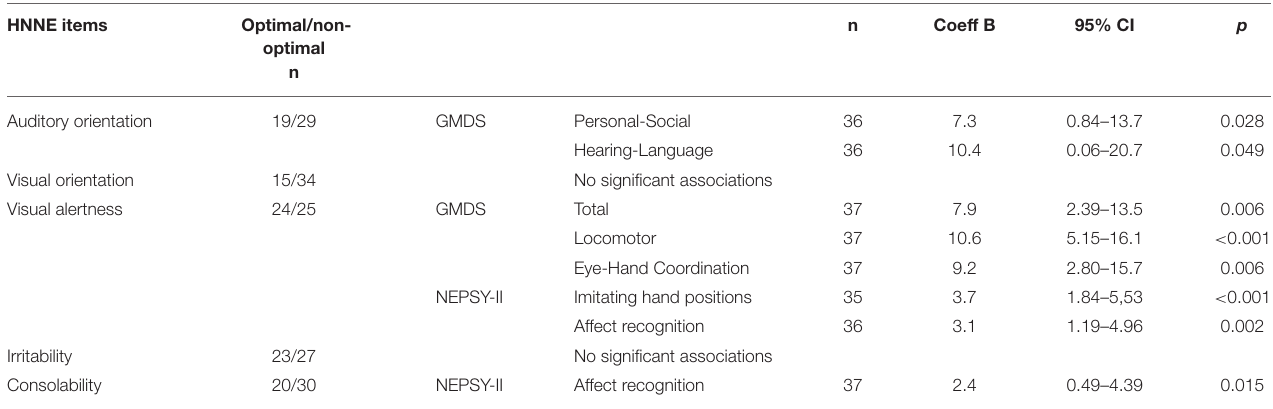
TABLE 3 | Associations between the performance on the HNNE behavior items and DQs in GMDS and standard scores in NEPSY-II. HNNE items Optimal/non- optimal